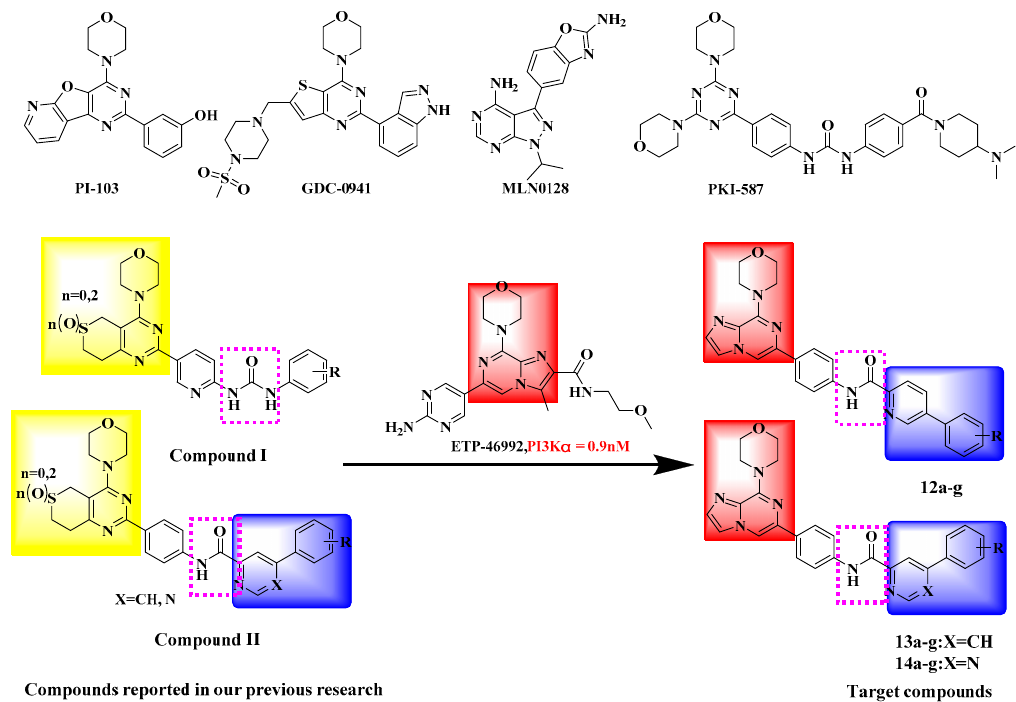
Figure 1. Structures of some reported PI3K pathway inhibitors and design strategy of the target compounds.